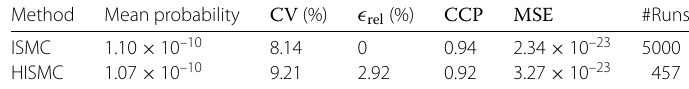
Table 4 VCO: ISMC versus HISMC probability estimation